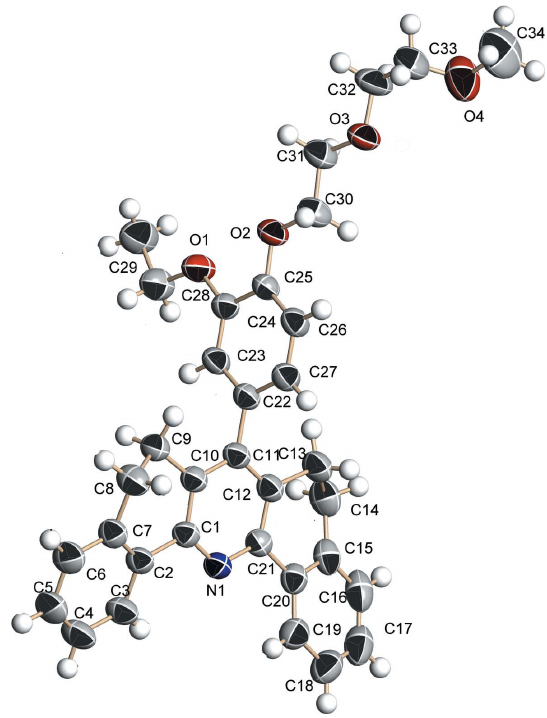
Figure 1 The molecular structure of the title compound showing 50% displace- ment ellipsoids. Only the major disorder component of the methoxyeth- oxy–ethoxy side chain is